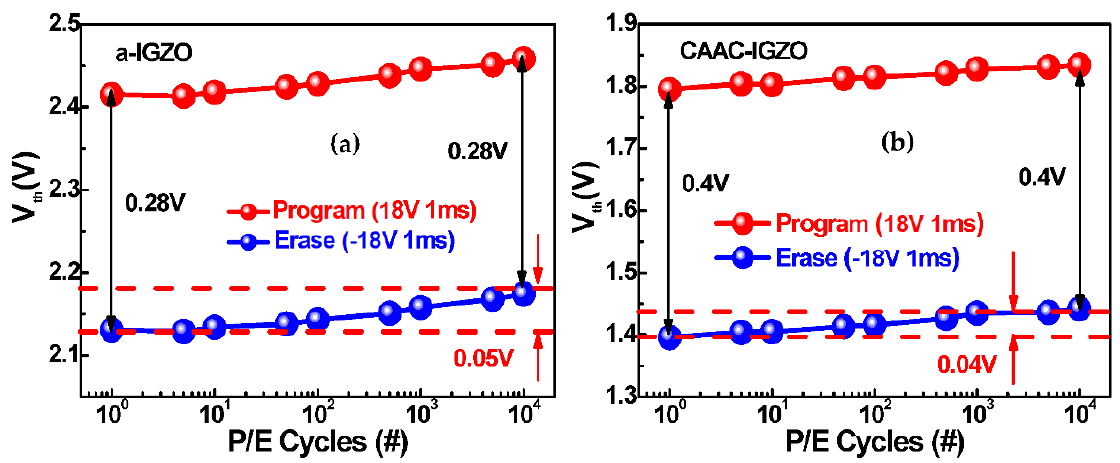
Figure 10. Endurance characteristics of ( a ) a -IGZO and ( b ) CAAC-IGZO devices tested up 10 4 cycles.